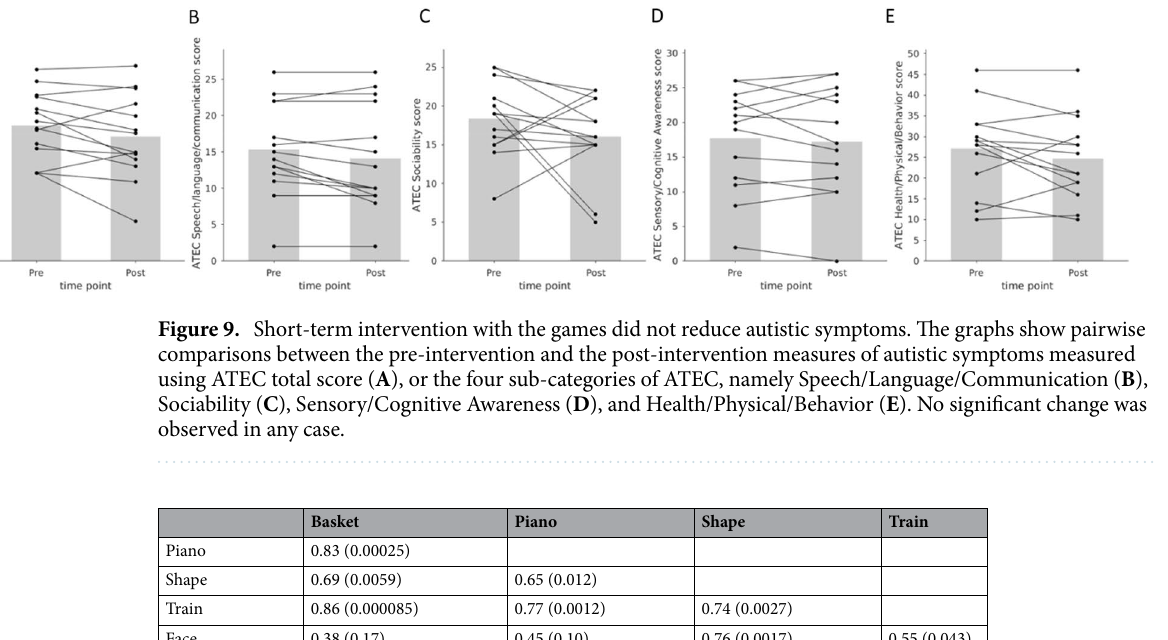
Figure 8. Short-term intervention with the games did not improve working memory. The graphs show pairwise comparisons between the pre-intervention and the post-intervention measures of working memory: The Corsi block span ( A ) and the Corsi total score ( B ). No significant change was observed with either measure. Both plots have N = 14 pairs of points, each corresponding to a subject, but some lines are overlapping.